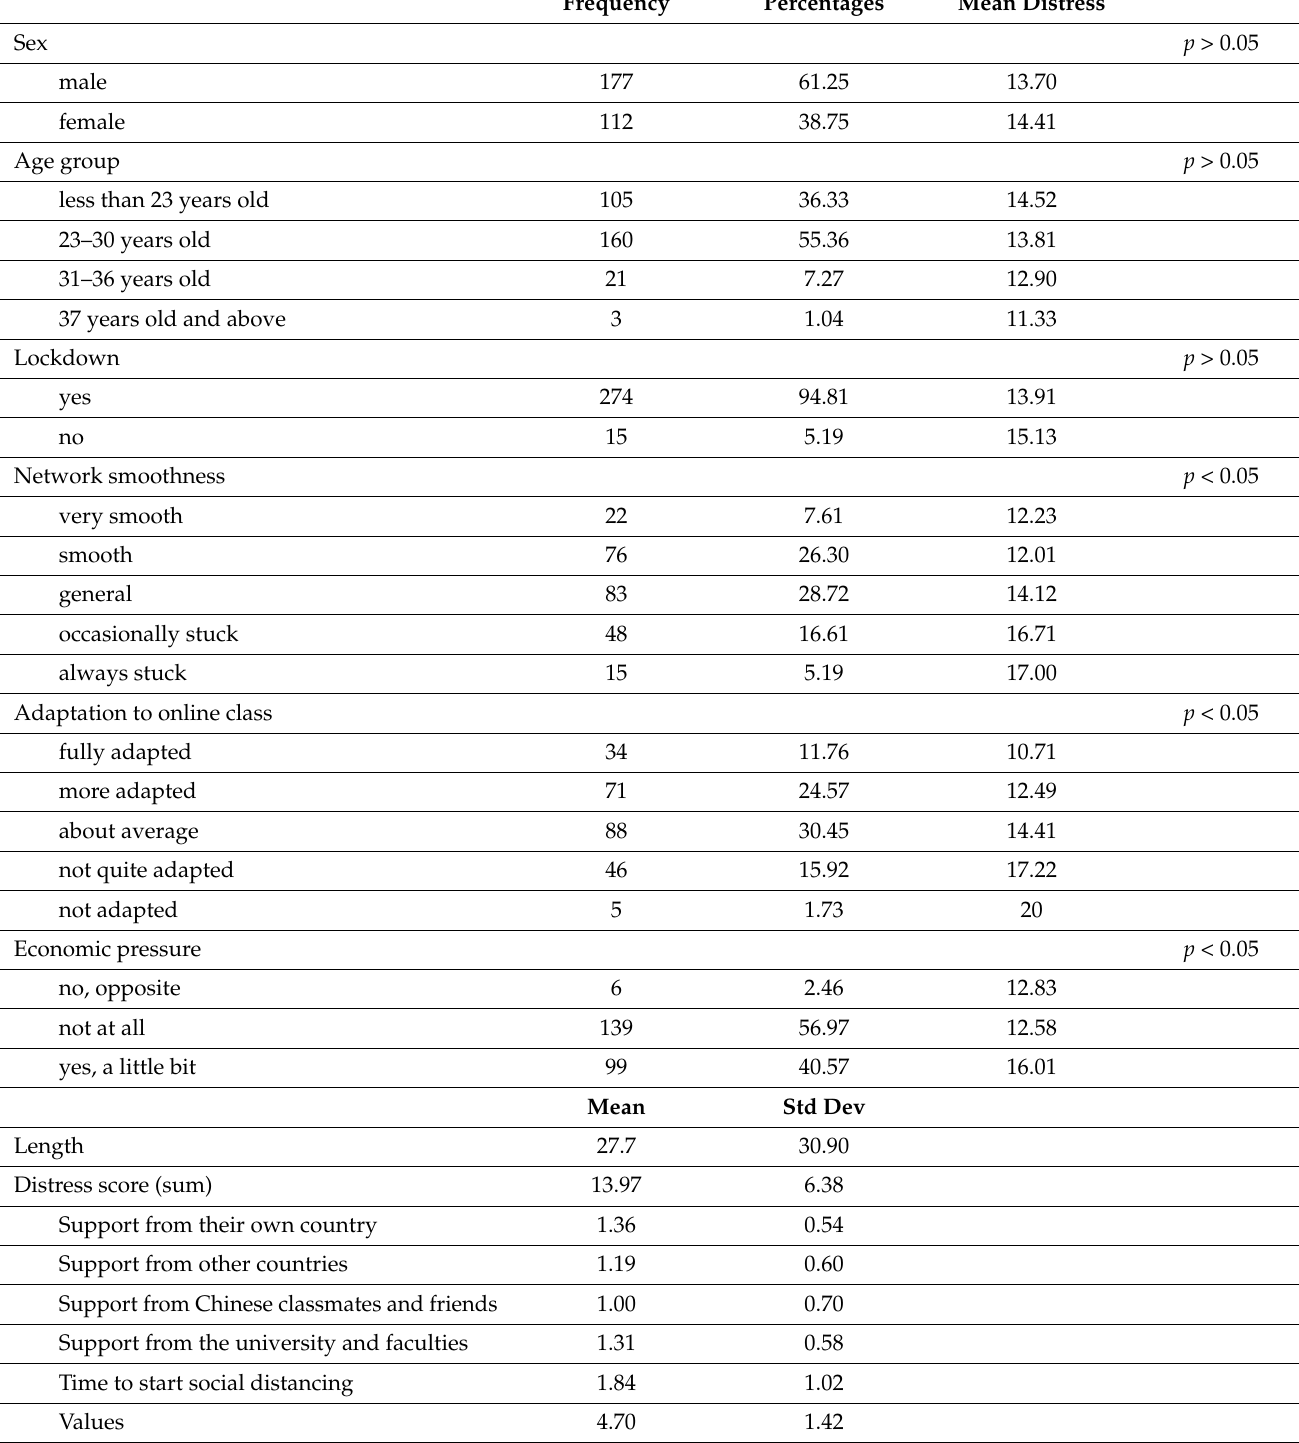
Table 1. Description of the